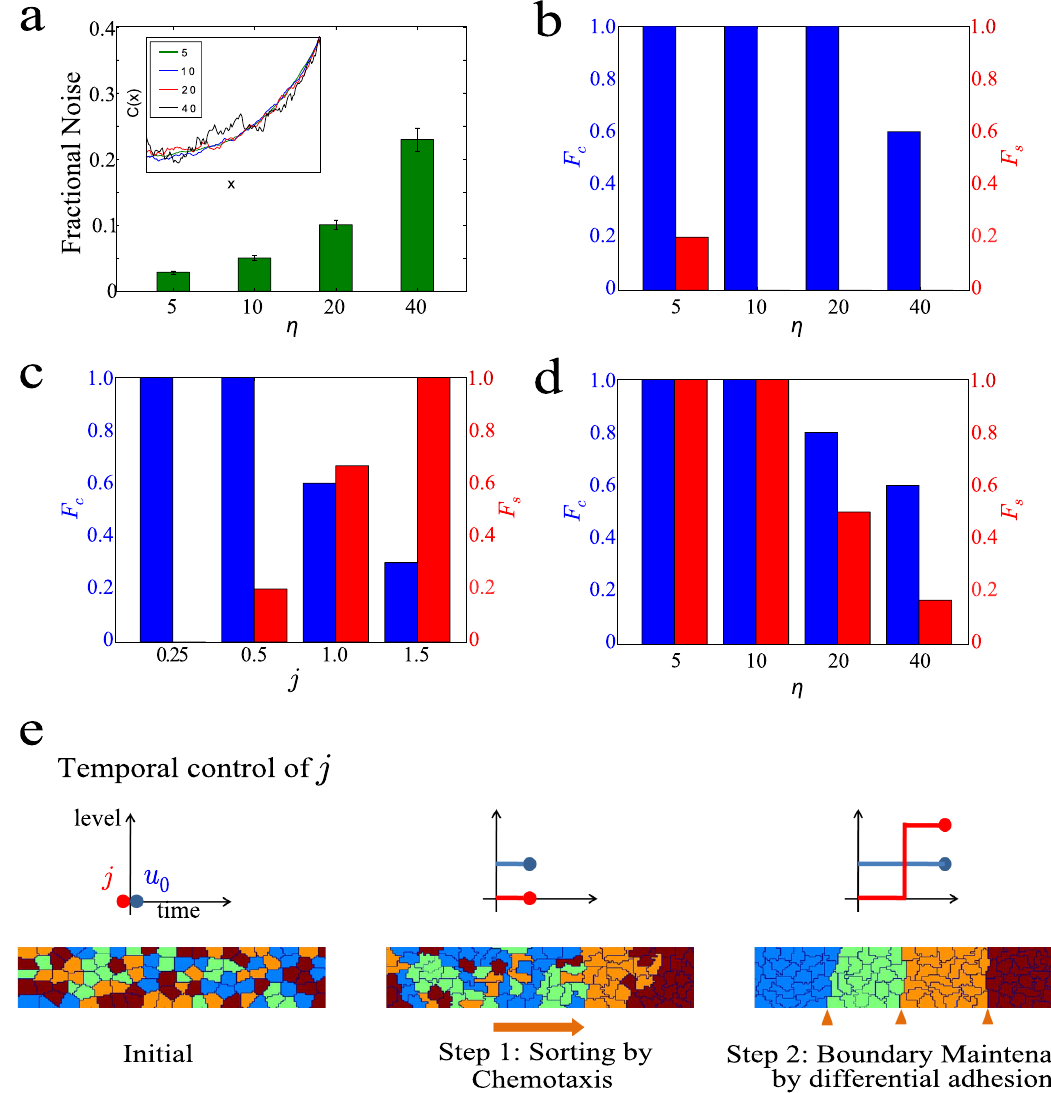
Figure 5. Chemotaxis coupled with delayed differential adhesion response yields optimal sorting in presence of noise. ( a ) Fractional noise in the morphogen gradient for different values of g . (Inset) Representative traces of morphogen concentration, C x ð Þ , along x for different values of g . ( b ) Bar graphs of fraction of correct and stable sorting, F c (blue) and F s (red), respectively, for different values of g at m o = 0.75 and j = 0.25. 10 runs were performed for each value of g . ( c ) Bar graphs of fraction of correct and stable sorting, F c (blue) and F s (red), respectively, for different values of j at m o = 0.25 and g = 10. 10 runs were performed for each value of j . ( d ) Bar graphs of fraction of correct and stable sorting, F c (blue) and F s (red) respectively, for different values of g at m o = 0.75 and j = 0 for the first 500 MCS, followed by m o = 0.75 and j = 1.5 for the subsequent 2000 MCS. 10 runs were performed for each value of g . ( e ) Illustration for the chemotaxis coupled with delayed differential adhesion response model.